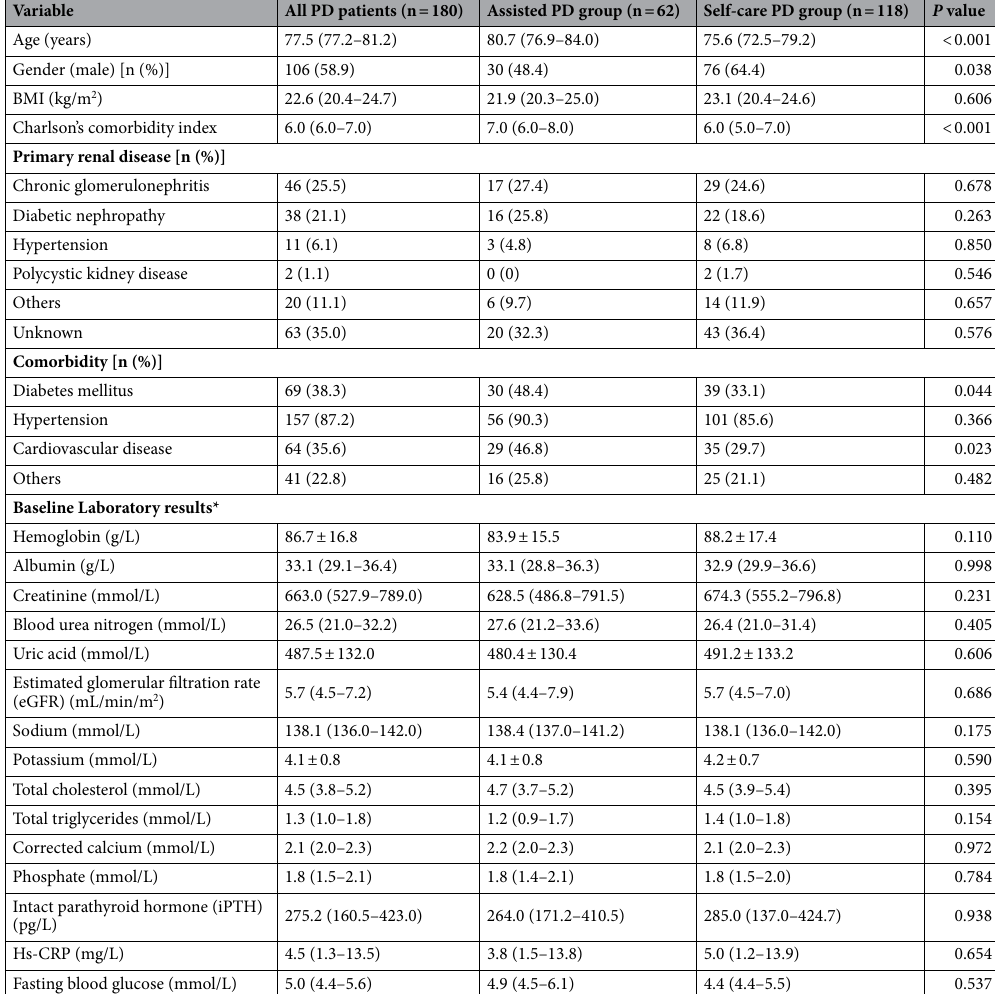
Table 1. Demographic and laboratory data of the study patients. Values expressed as mean ± standard deviation, median (25th–75th percentile), or absolute numbers with percentages [n (%)]. Abbreviations: BMI body mass index, Hs-CRP high-sensitivity C reaction protein, Corrected calcium total calcium (corrected by albumin), Kt/Vurea urea kinetics, CrCl creatinine clearance, RRF residual renal function, nPCR normalized protein catabolic rate, D/Pcr peritoneal transport characteristics. Baseline Laboratory results* was evaluated at PD initiation (within one week before PD catheterization).